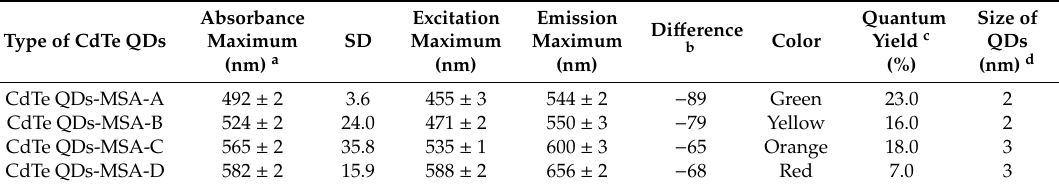
Table 2. Spectrometric characterization of various types of CdTe